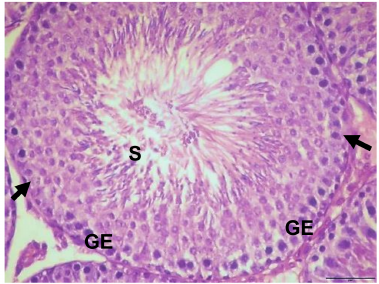
Figure 3. Section of testis of rats treated with EVOO for 15 days showing normal seminiferous tubules with normal germinal epithelium, Sertoli cells (arrow) (GE), and sperm (S) ( × 400).